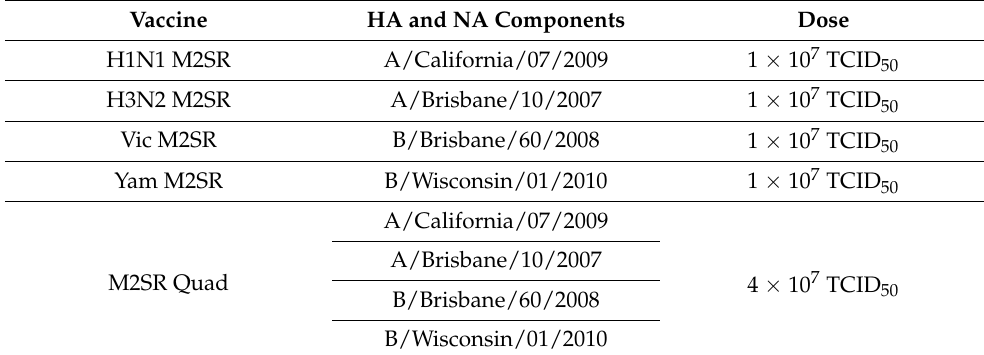
Table 1. M2SR Vaccine Candidates for Ferret Study.